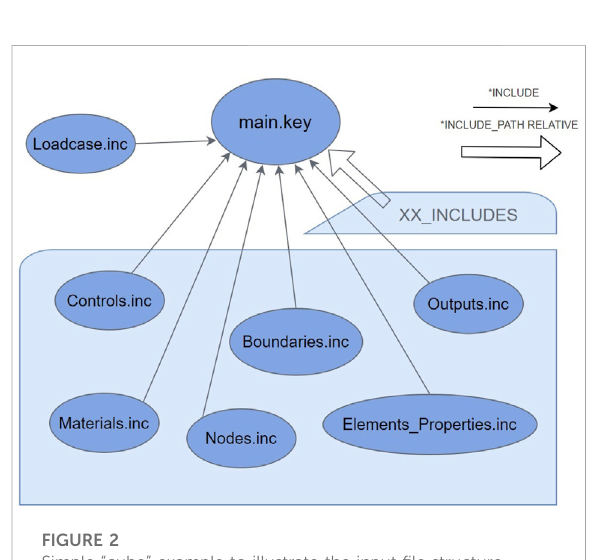
FIGURE 2 Simple “ cube ” example to illustrate the input fi le